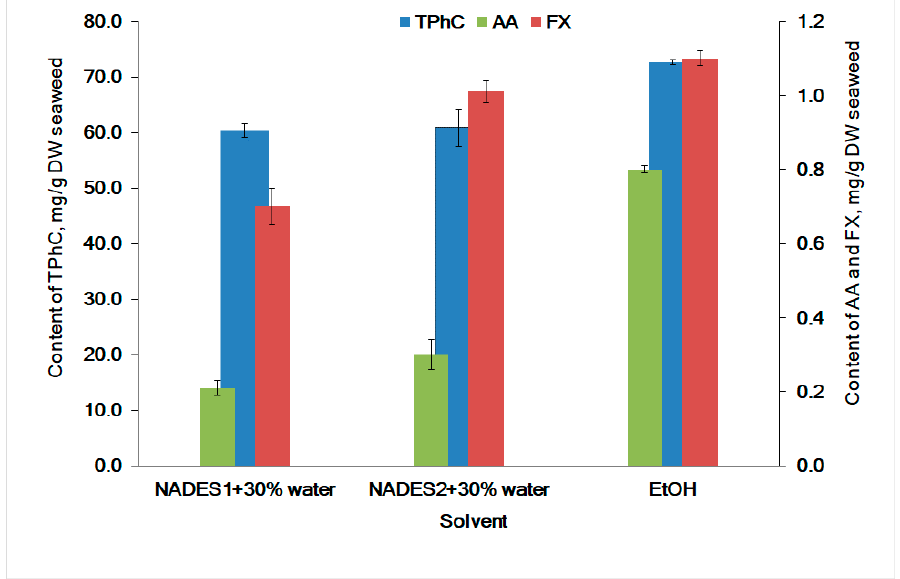
Figure 4. Comparison of extraction efficacy of ascorbic acid (AA), total phlorotannins (TPhC), and fucoxanthin (FX) from F. vesiculosus with NADES (CE at 60 °C) and with EtOH by exhaustive extraction (PE, 25 °C).